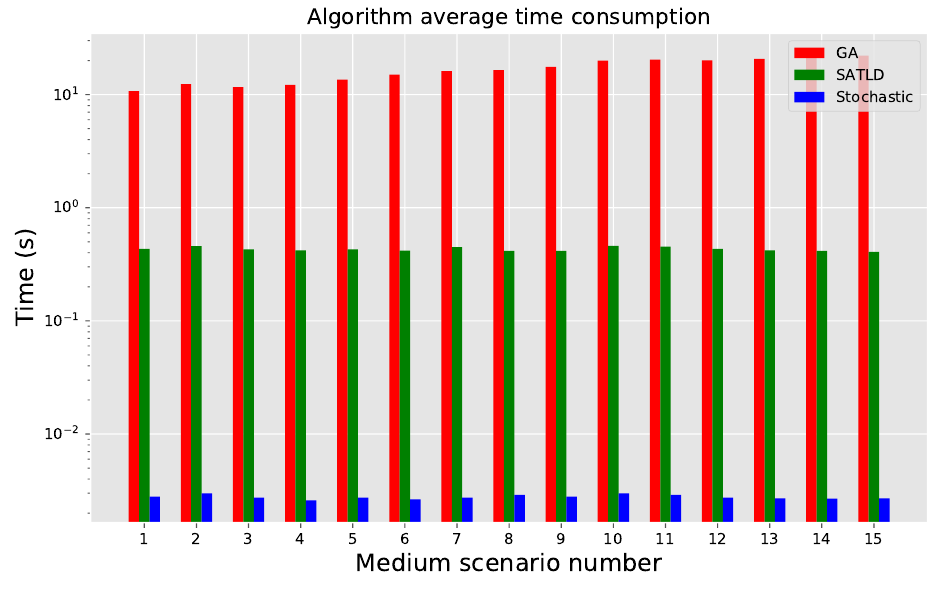
Figure 9. Average time consumption in medium scenario.